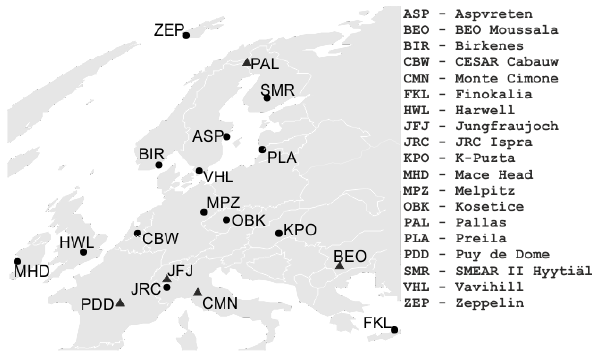
Fig. 3. Stations and station codes of EUSAAR stations used in EU- CAARI (adapted from Asmi et al.,